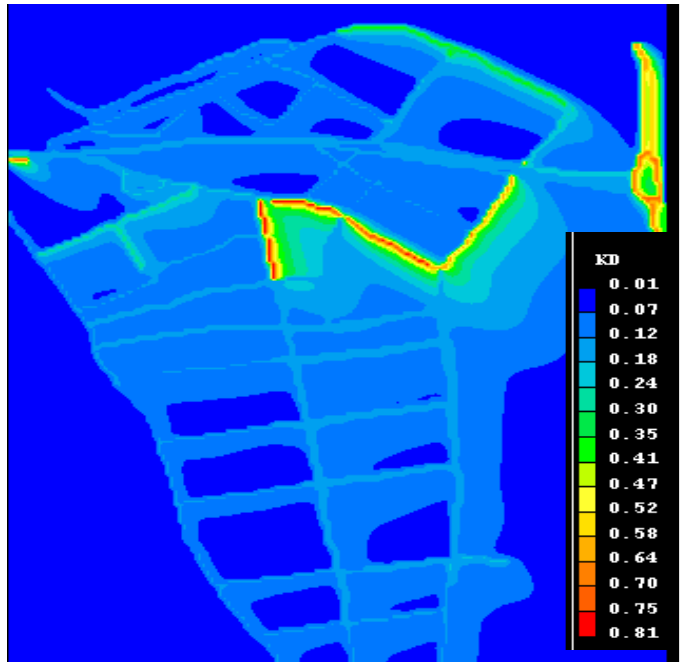
Fig. 5 . Results of SP dispersion simulation for January 30, 2006 (“out-of rush” hours) in Žvėrynas district area Table 5. Comparison of experimental results (of January 30, 2006 during “out-of –rush” hours) and theoretically calculated ones Points 3 9 12 18